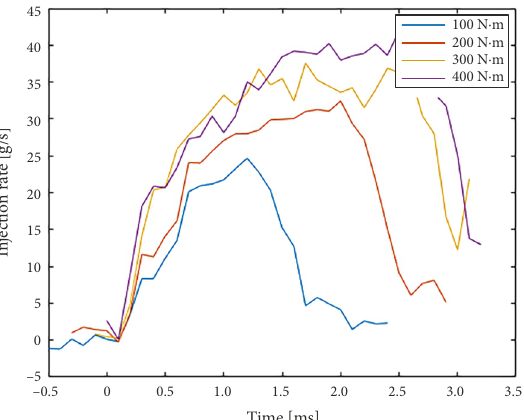
Figure 10. Measured injection rates of the four engine operating points with 0° plug valve position, 0.1 MPa backpressure